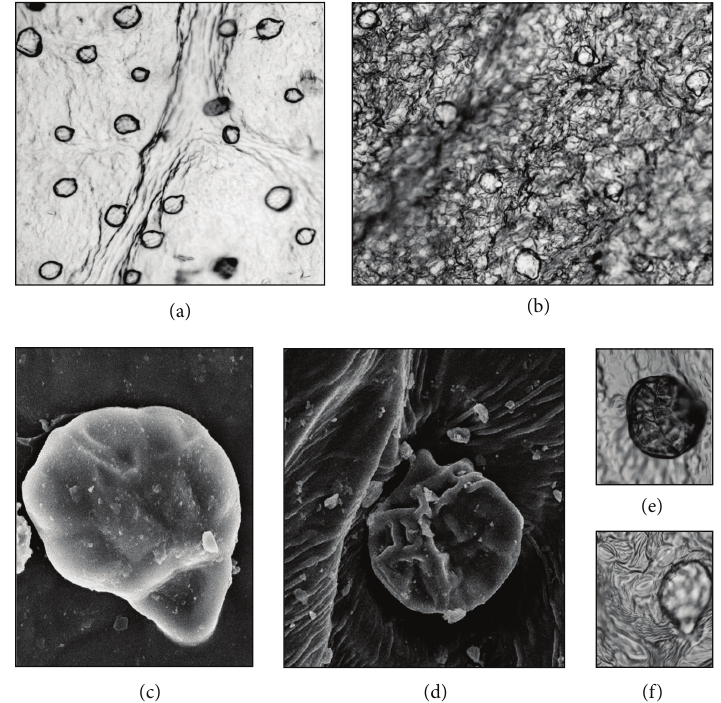
Figure 2: (a) and (b): stereomicroscopic picture of D. composita and D. floribunda essential-oil glandular trichomes at 100x, respectively. (c) and(d):scanningelectronmicroscopicpictureof D.composita and D.floribunda essential-oilglandulartrichomesat2.74 kkX,respectively.(e) and (f): 400x stereomicroscopic views of magnifications of essential-oil glandular trichomes of D. composita and D. floribunda, respectively. All were viewed